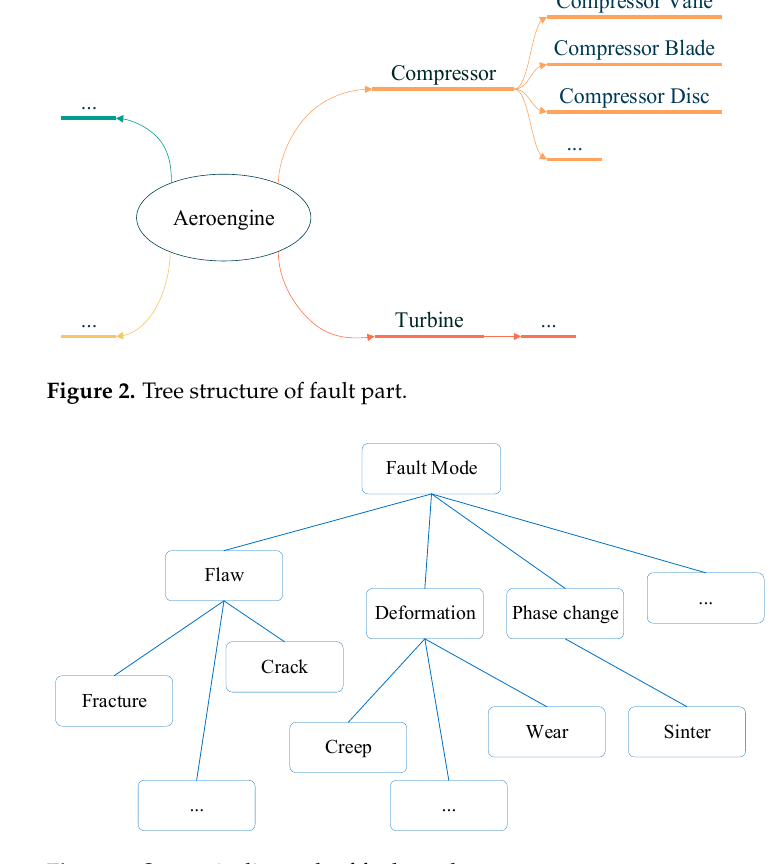
Figure 3. Semantic diagraph of fault mode.